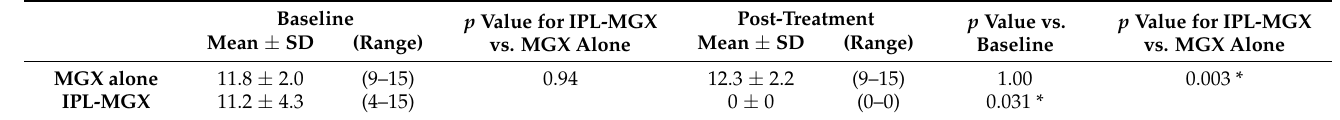
Table 3. Standard Patient Evaluation of Eye Dryness (SPEED) validated questionnaire score (0–28) of the patients with chalazion in intense pulsed light (IPL)–meibomian gland expression (MGX) ( n = 6) and MGX alone ( n = 6) groups before and four weeks after the final treatment session. p Value for IPL-MGX vs. MGX Alone